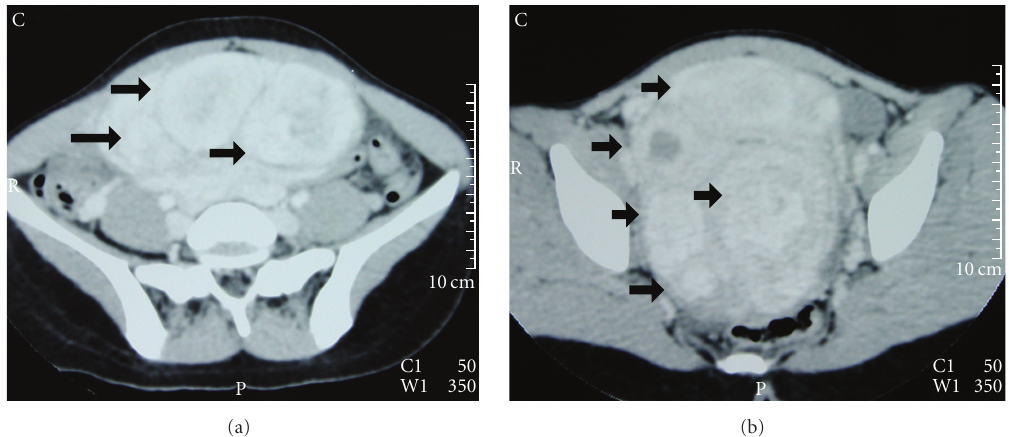
Figure 1: Transverse postcontrast CT images (portal phase) reveal numerous uterine leiomyomas of variable size (arrows). The masses show inhomogeneous enhancement after contrast material